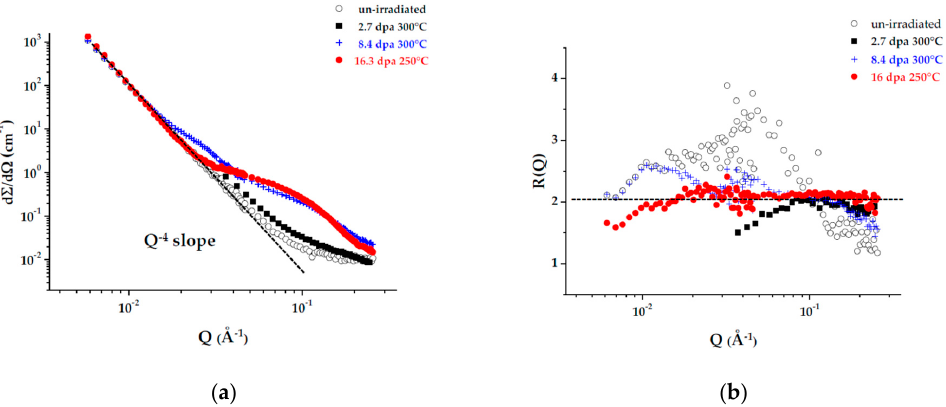
Figure 4. Nuclear SANS cross sections ( a ) and R ( Q ) ( b ) for un-irradiated reference Eurofer97 (empty circles) and for Eurofer97 irradiated 2.7 dpa 300 °C (squares), 8.4 dpa 300 °C (crosses), 16.3 dpa 250 °C (full circles); experimental results from References [10,14].